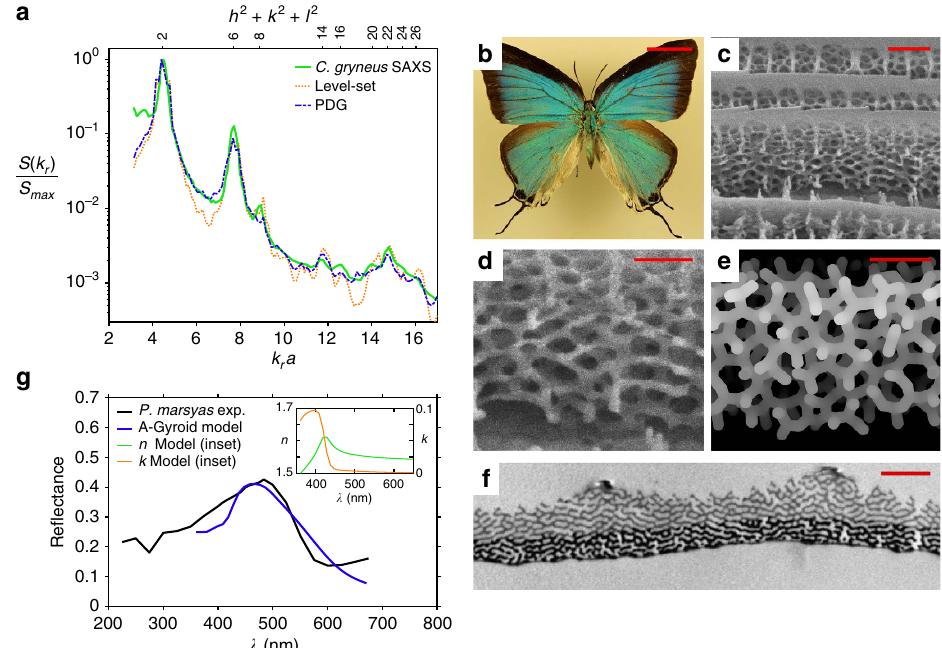
Figure 6 | LSU in butterfly scales. Comparison with SAXS data of level-set and partially disordered gyroid models of wing scales in the butterfly C. gryneus ( a ). Specimen of Ps. marsyas ( b ) and FIB section of one of its blue scales ( c ), imaged with 52 (cid:2) tilt in the FIB. Detail ( d ), taken from ( c ), compared with a projection of an amorphous gyroid model ( e ). Transmission electron micrograph of a Ps. marsyas scale cross-section ( f ). Comparison of experimental reflectance data from a large wing area to an amorphous gyroid scale model ( g ). Scale bars, 1cm ( b ); 1 m m ( c ); 500nm ( d , e ); and 1.5 m m ( f ). The TEM section ( f ) is reproduced with permission from Ve´rtesy et al. 52 . TEM, transmission electron